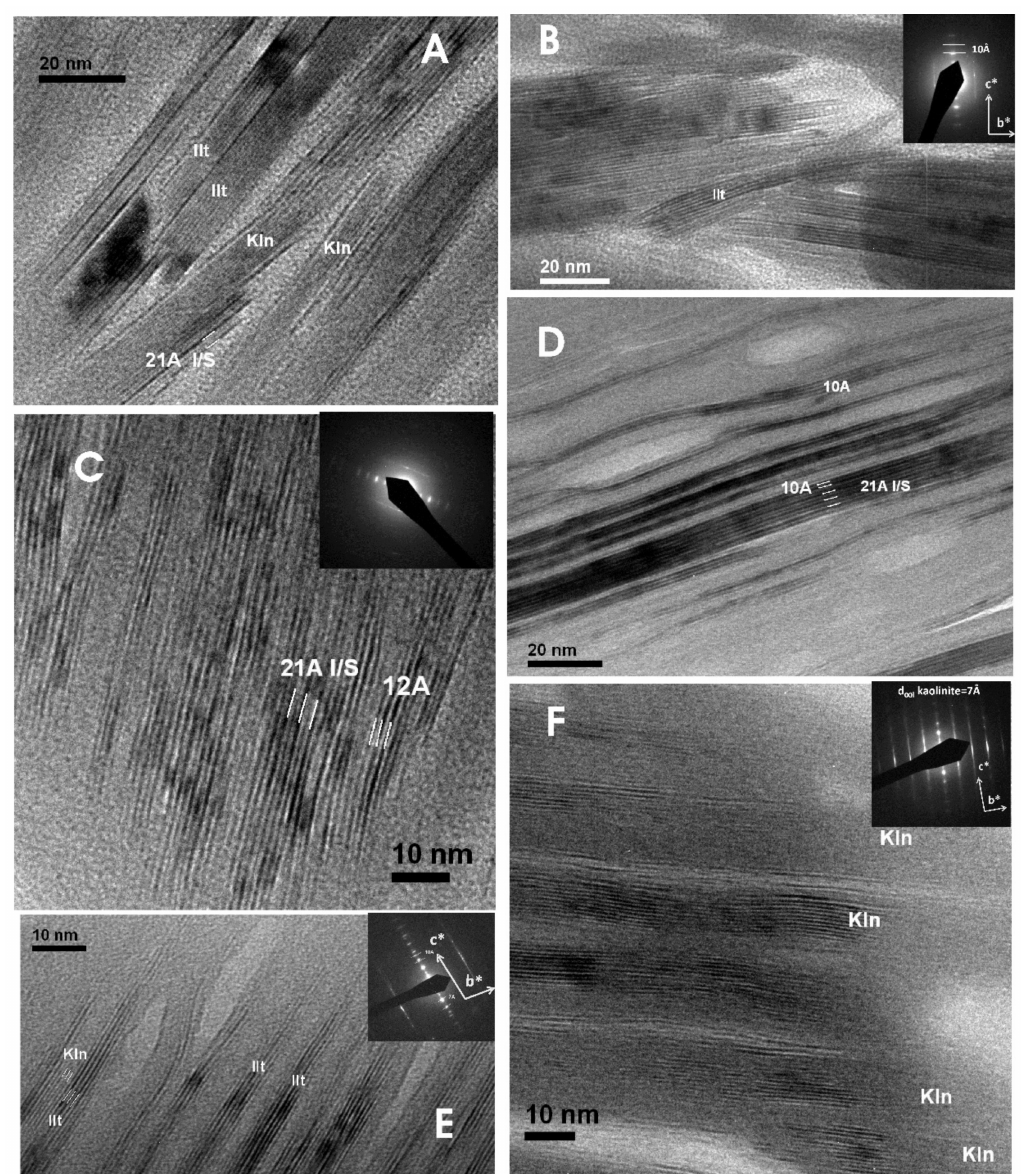
Figure 7. HRTEM images corresponding to the fine clay matrix of the rocks. ( A ) Clay matrix formed by illite (Ilt), kaolinite (kln) and I/S mixed layers. ( B ) Frayed oblique illite (Ilt) packets, inset shows disordered SAED suggesting a 1 Md polytype. ( C ) Complex mixed-layered minerals formed by Sm-layers and IS phases, inset shows disordered polytypes (1 Md type). ( D ) I-S phases interstratified with illite layers (10 Å spacing). ( E ) Random mixed-layered illite/kaolinite (Ilt/Kln). ( F ) Pure kaolinite areas with layer terminations and non-straight lattices, inset shows SAED pattern suggesting disordered